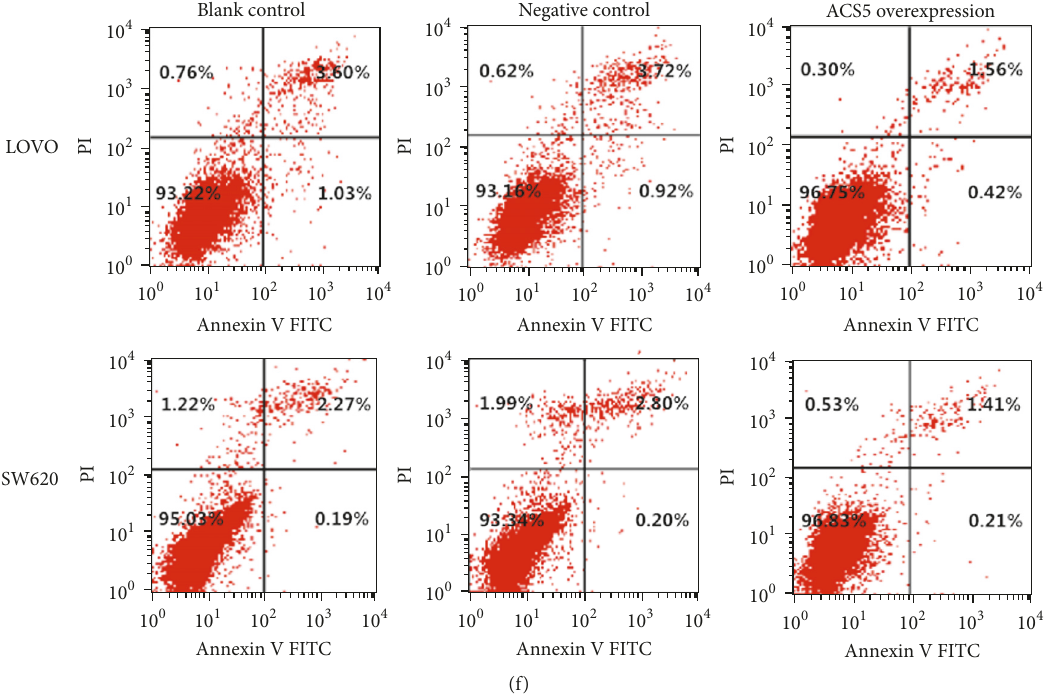
Figure 5: Effect of ACS5 on the apoptosis of CRC cells. ((a), (b), (e)) The percentage of early and late apoptotic cells was higher in HT29 and SW480 cells with ACS5 knockdown than that in negative control or blank control cells. ((c), (d), (f)) The percentage of late apoptotic cells was lower in LOVO and SW620 cells with ACS5 overexpression than that in negative control or blank control cells. ∗ 𝑃 < 0.05 , ∗∗ 𝑃 < 0.01 versus negative control or blank control